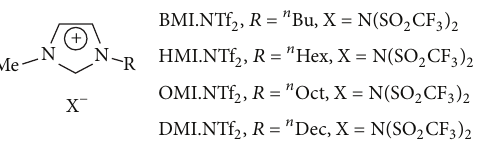
Figure 1: Schematic representation of ILs